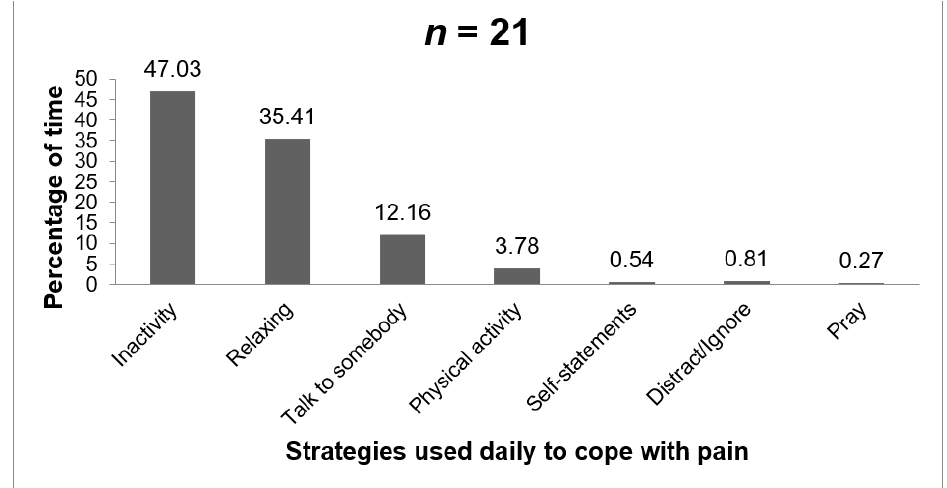
Figure 5. Use of strategies to cope with the pain (aggregate of daily reports).